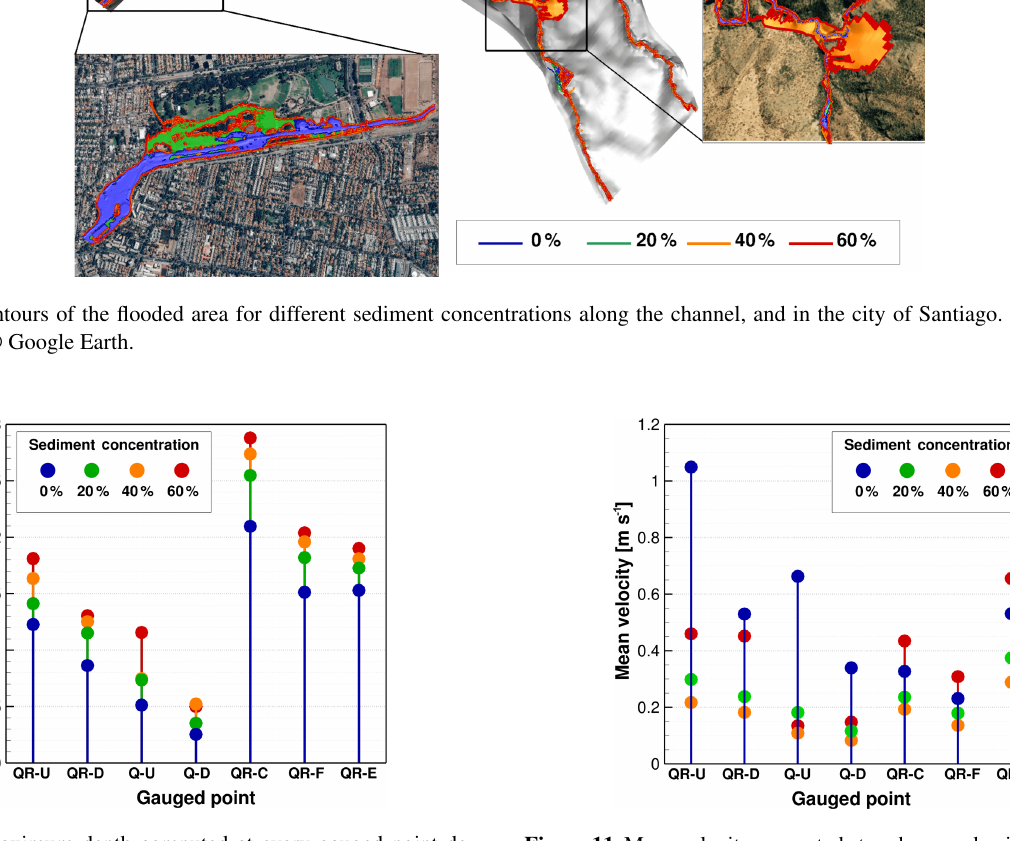
Figure 11. Mean velocity computed at each gauged point depending on the sediment